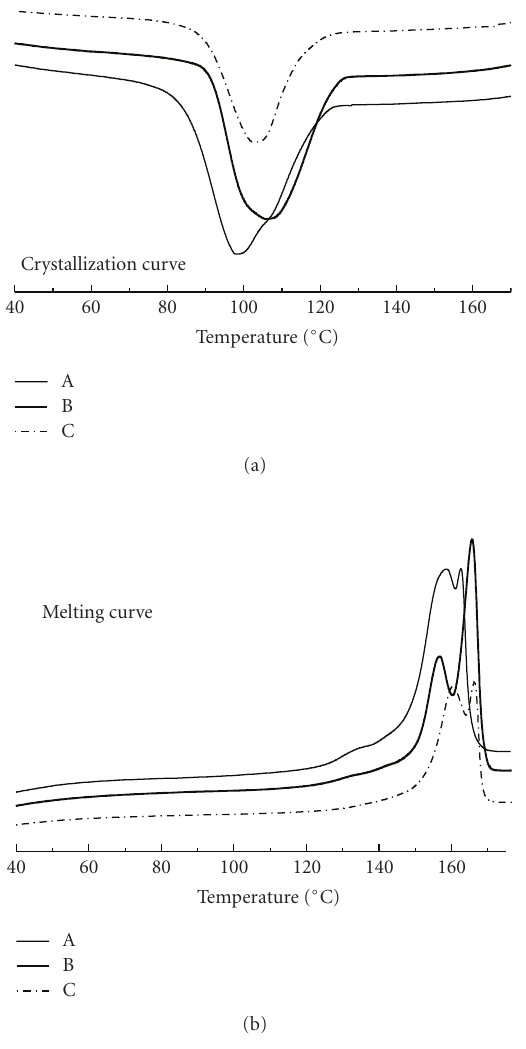
Figure 8: The E ff ect of antioxidants on the thermal properties of PLA by DSC. Sample A: without antioxidant; sample B: adding antioxidant before polymerization; sample C: adding antioxidant 5 hours after polymerization